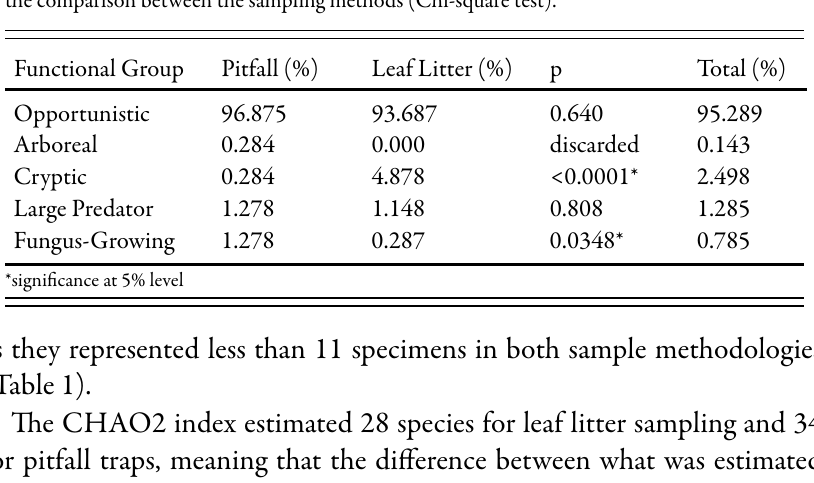
Table 2. Relative abundance of functional groups for each sampling methodology and their sum, the comparison between the sampling methods (Chi-square